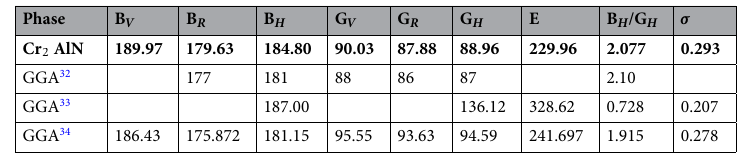
Table 6. The estimated values of isotropic bulk modulus B VRH , shear modulus G VRH , Young’s modulus E (all in GPa), B H /G H ratio and Poisson’s ratio ( σ ) for Cr 2 AlN for this work in bold, obtained from their second order elastic constants C ij . Other theoretical results are also included for